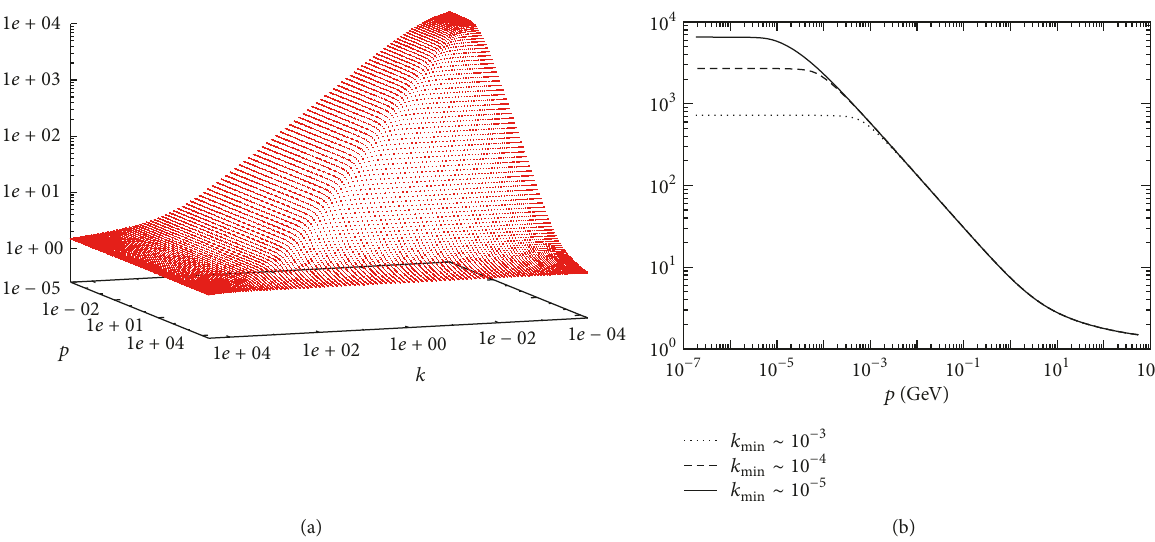
Figure 3: (a) The ghost form factor obtained in [26] from the solution of the renormalization group flow equations. Here, 𝑝 represents the momentum variable of the ghost form factor while 𝑘 is the infrared momentum cutoff of the flow equations. (b) Cuts through subfigure (a) at various values of the momentum scale 𝑘 of the flow equations.